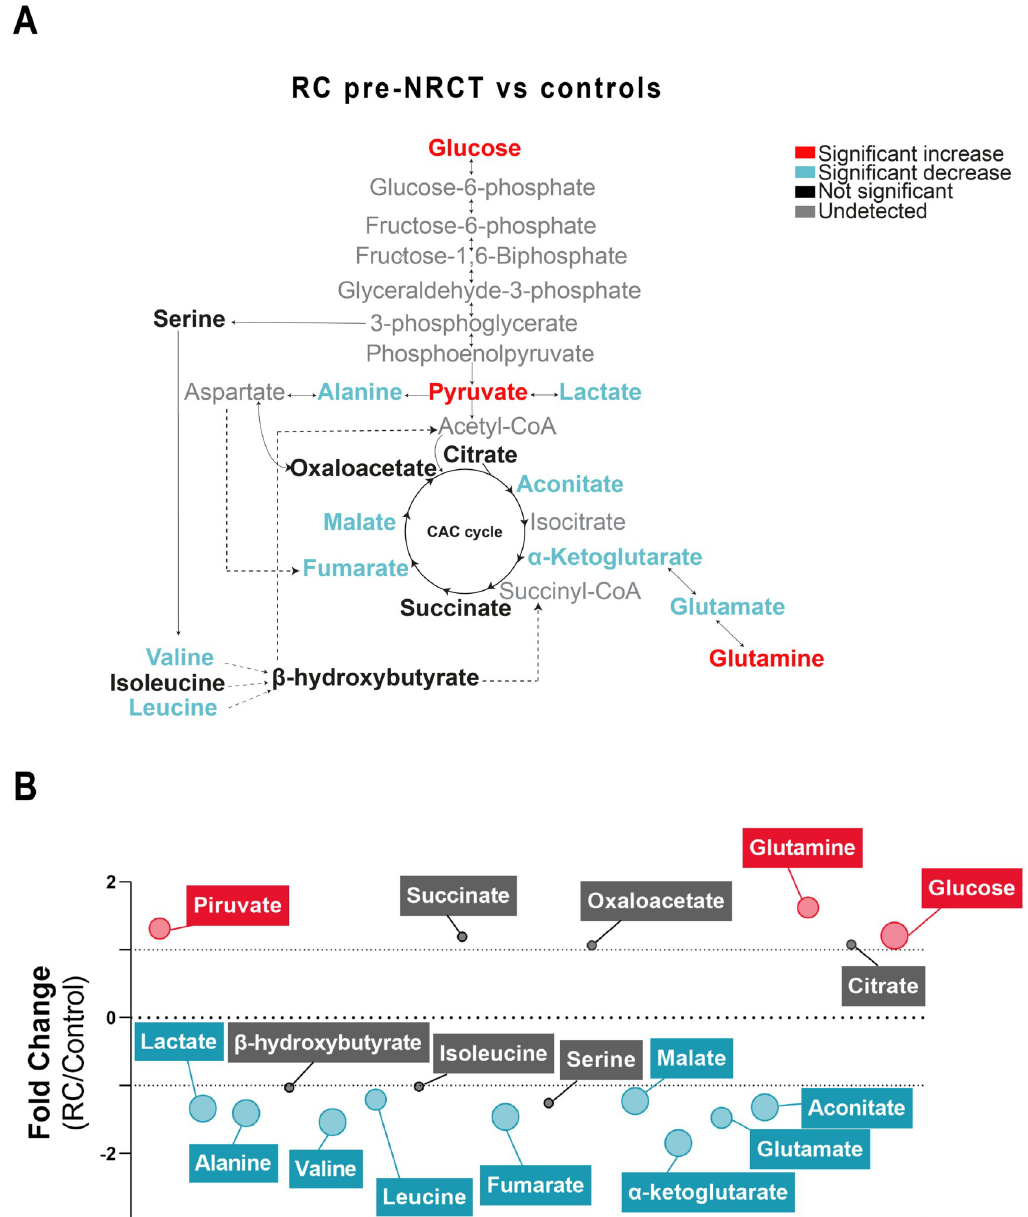
Fig 1. Plasma metabolic alterations in patients with Rectal Cancer (RC). (A) Schematized view of differences in metabolites related to the glycolytic pathway, citric acid cycle, and amino acid pathways between control and RC patients. Colours indicate statistical comparisons as shown in the legend. (B) Average fold changes of metabolite concentrations expressed as bubble plots. The bubble sizes estimate the magnitude of change. Colours represent a significant statistical increase (red), decrease (blue) or not significant (grey). NRCT: Neoadjuvant